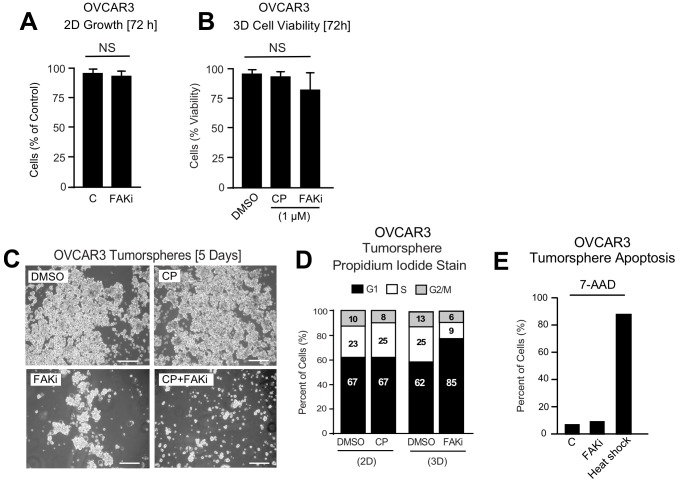
Small molecule FAK inhibition selectively inhibits OVCAR3 3D tumorsphere proliferation with effects on cell cycle but not cell apoptosis.(A) Growth of OVCAR3 cells in 2D culture + /- FAKi (VS-4718, 1 µM) over 72 hr. (B) Cell viability (trypan blue exclusion) of OVCAR3 cells grown in 3D (PromoCell) in the presence of DMSO, cisplatin (CP, 1 µM), or FAKi (1 µM). (A and B) Values are means + /- SD. NS, not significant. (C) Representative images of OVCAR3 tumorsphere formation (PromoCell, 5 days) in DMSO, cisplatin (CP, 1 µM), FAKi (1 µM), or CP plus FAKi (1 µM each). Scale is 1 mm. (D) OVCAR3 cells grown in 2D or 3D as tumorspheres for 3, treated with DMSO or FAKi (VS-4718, 1 µM), stained with propidium iodide, and analyzed by flow cytometry. Percentage of cells in G0, G0/G1, S, and G2/M phase of the cell cycle was determined using FlowJo. (E) Percent of OVCAR3 tumorsphere cell 7-AAD (7-aminoactinomycin D) staining when treated with DMSO (control, (C), FAKi (VS-4718, 1 µM 24 hr) or heat shock (100°C, 15 min) by flow cytometry. (D and E) Values are means from two independent experiments.